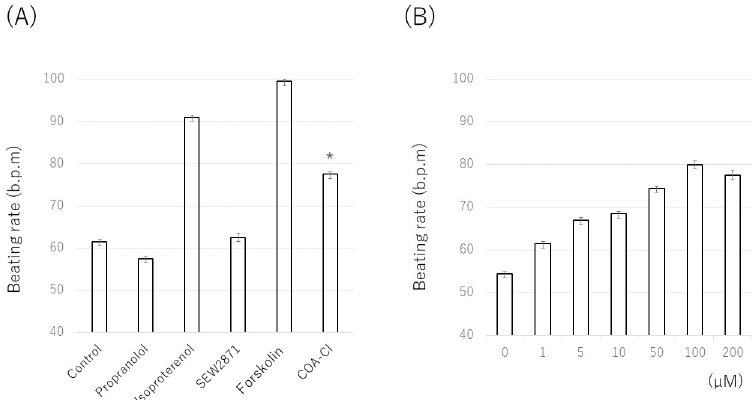
Fig 4. COA-Cl, ISO and FSK significantly stimulated the beating rates. PRP suppressed the beating rate. No marked changes were observed with SEW2871. The data were obtained from four individual experiments, each of which was performed four times. The average values ( ± SEM) normalized with reference to the basal condition in the presence of PBS (A). COA-Cl stimulated the beating rates in a concentration-dependent manner. Seven different concentrations of COA-Cl were prepared: 0 M (baseline), 1 μ M, 5 μ M, 10 μ M, 50 μ M, 100 μ M, and 200 μ M. These spheroids were exposed to these compounds for 30 min and recorded for 30 s using a BZX-710. The data were obtained from four individual experiments, each of which was performed four times. The average values ( ± SEM) were normalized with reference to the basal condition in the presence of PBS (B).